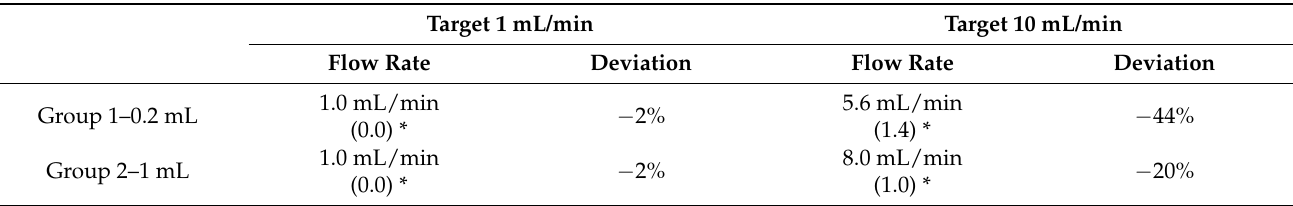
Table 2. Experimental injection flow rates. Deviations were calculated from the targeted injection flow rates (i.e., 1 mL/min or 10